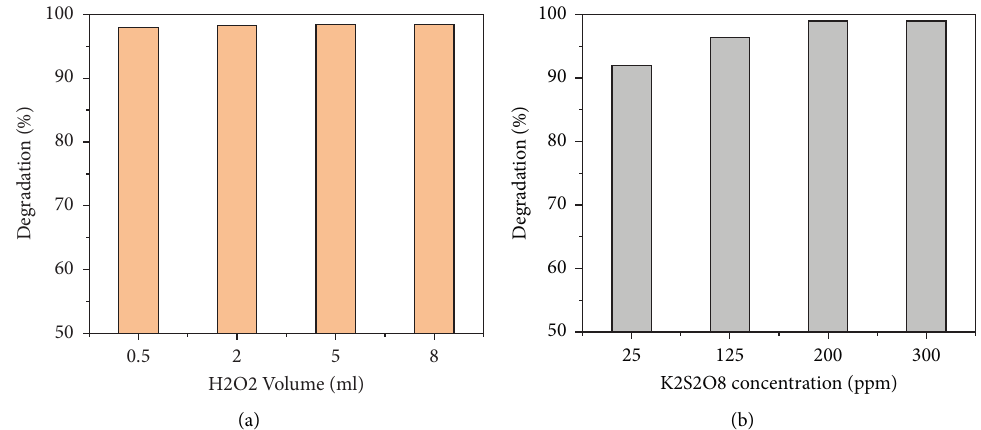
Figure 8: (a) Eosin yellowish degradation at diferent interval times and (b) the corresponding kinetic linear simulation curves (ln( C time).